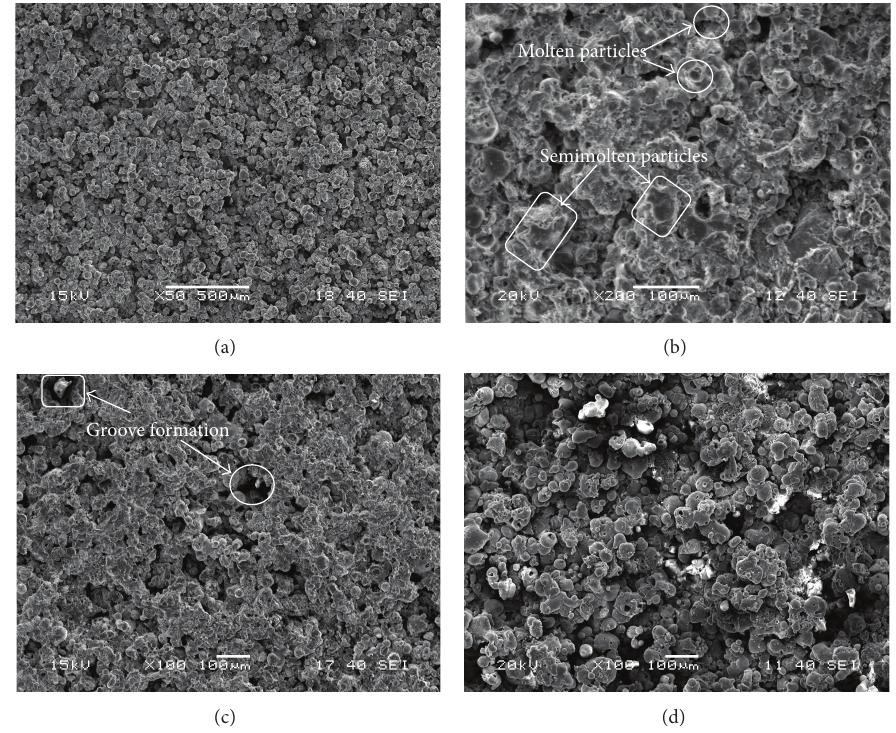
Figure 5: SEM micrographs of worn surfaces of the BGM